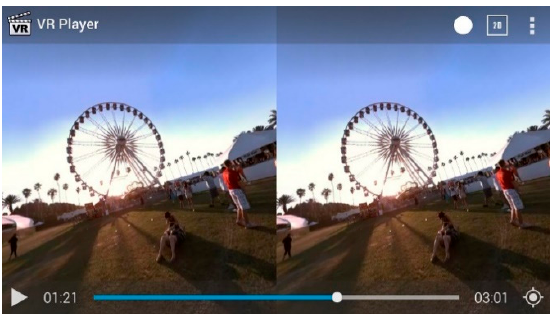
Figure 2. VR Player Free (VIMERSIV, Inc., Terrebonne, QC, Canada, www.vrplayer.com) playback screen.